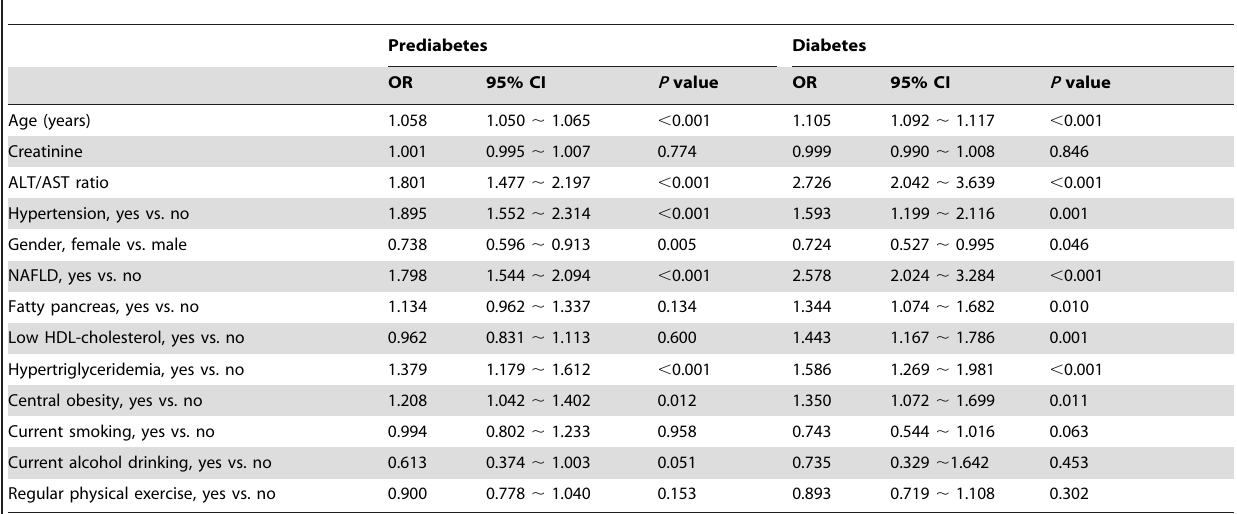
Table 2. Logistic regression analysis for factors associated with prediabetes and diabetes in study subjects.